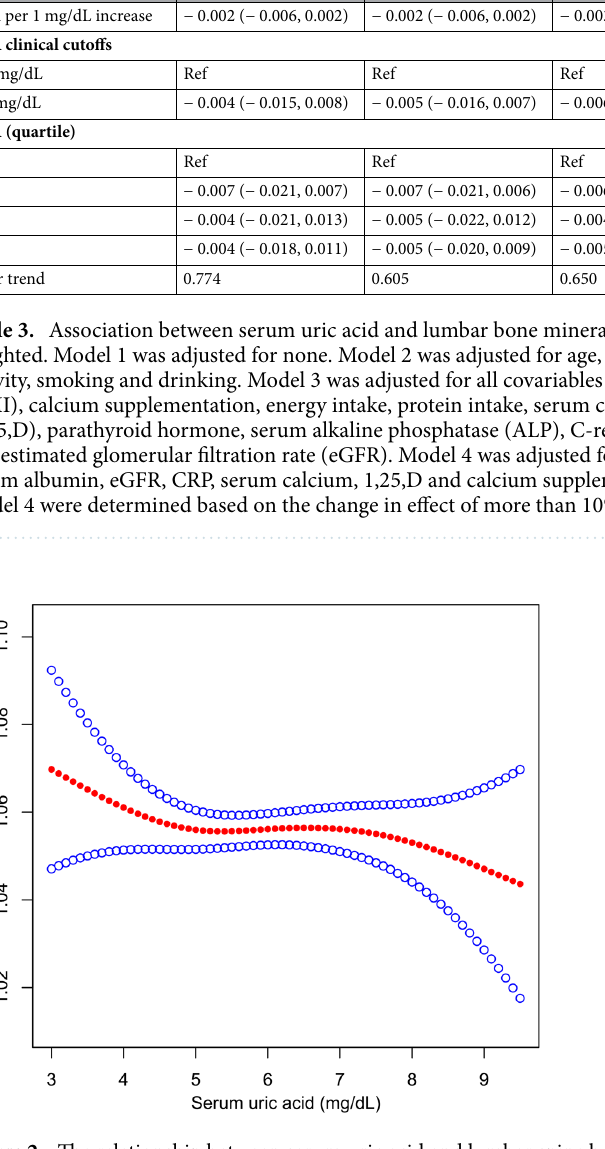
Figure 2. The relationship between serum uric acid and lumbar spine bone mineral density . A linear association between them was detected after adjusting for age, race/ethnicity, education, physical activity, smoking, drinking, body mass index, calcium supplementation, energy intake, protein intake, serum calcium, serum phosphorus, 25-OH-D, parathyroid hormone, serum alkaline phosphatase, C-reactive protein, serum albumin and estimated glomerular filtration